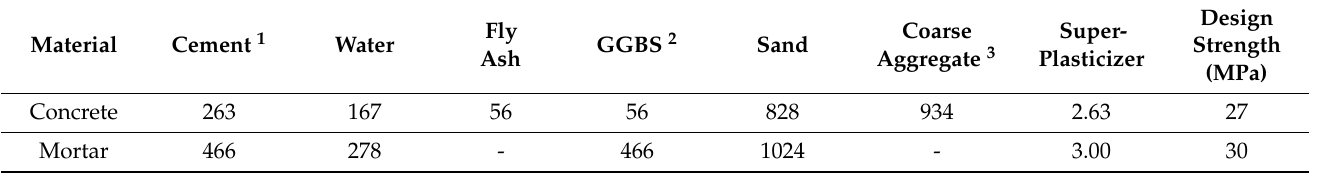
Table 1. Mix composition of concrete and mortar (unit: kg/m 3 ).